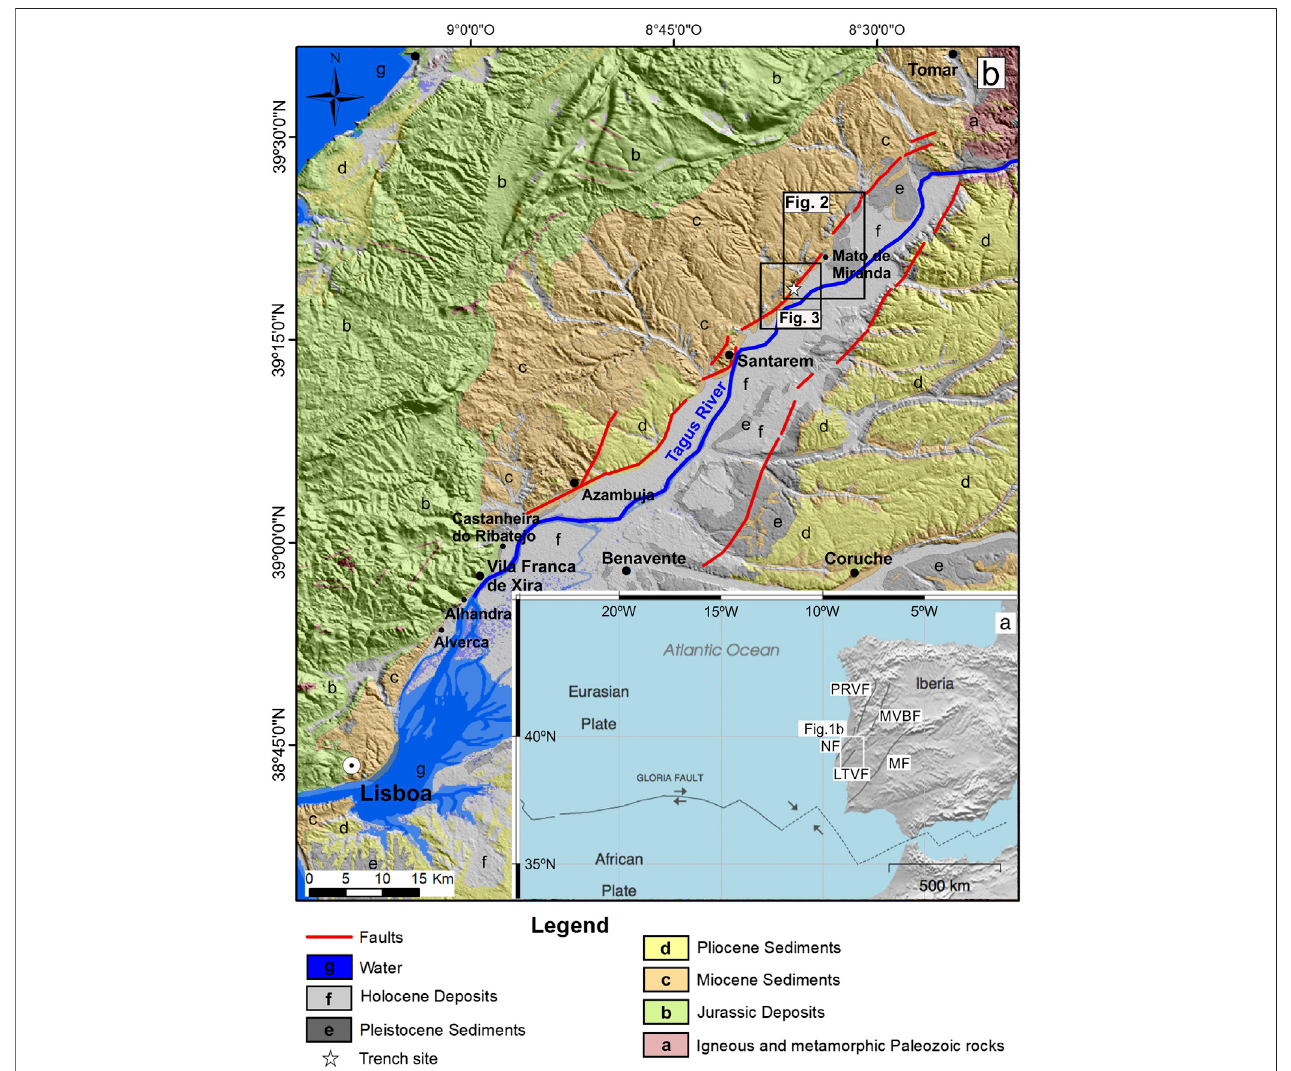
FIGURE 1 | General tectonic and geological setting of the study area. (A) Tectonic Plates and main basement faults of Western Iberia: PRVF- Penacova – Régua – Verin Fault; MVBF-Manteigas – Vilariça – Bragança Fault; LTVF Lower Tagus Valley Fault; MF- Messejana Fault; (B) LTVFZ traces (depicted in red) superimposed on the geological map and 0.5 m resolution DEM. The location of Figure 2 is outlined with a rectangle.